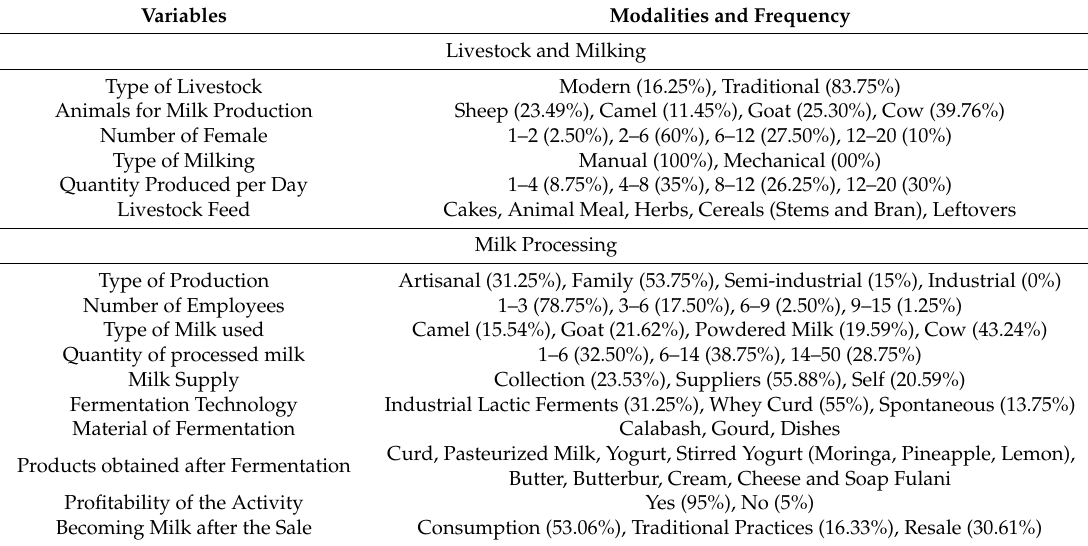
Table 2. Livestocking and milk production for fermentation.